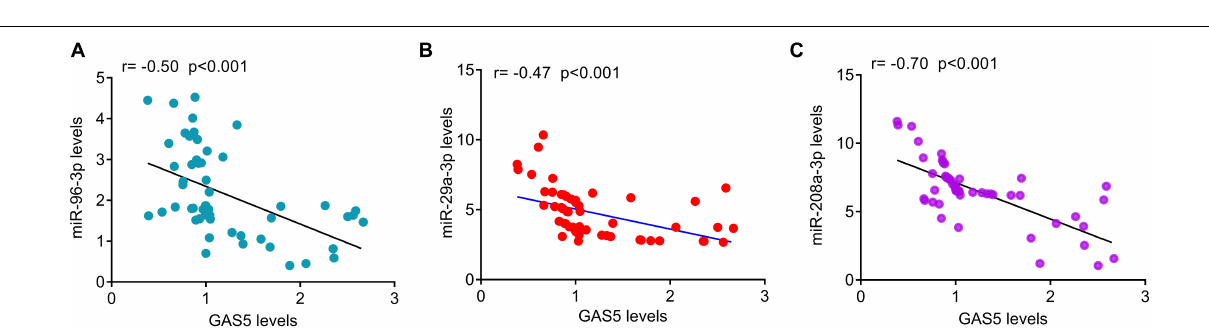
FIGURE 2 | The correlation of serum GAS5 levels with serum miRNAs levels in patients with T2DM. (A) Serum GAS5 levels were negatively correlated with miR-96-3p levels in patients with type-2 diabetes ( r = –0.50, p < 0.001). (B) Serum GAS5 levels were negatively correlated with miR-29a-3p levels in patients with type-2 diabetes ( r = –0.47, p < 0.001). (C) Serum GAS5 levels were negatively correlated with miR-208a-3p levels in patients with type-2 diabetes ( r = –0.70, p < 0.001). r: Spearman correlation